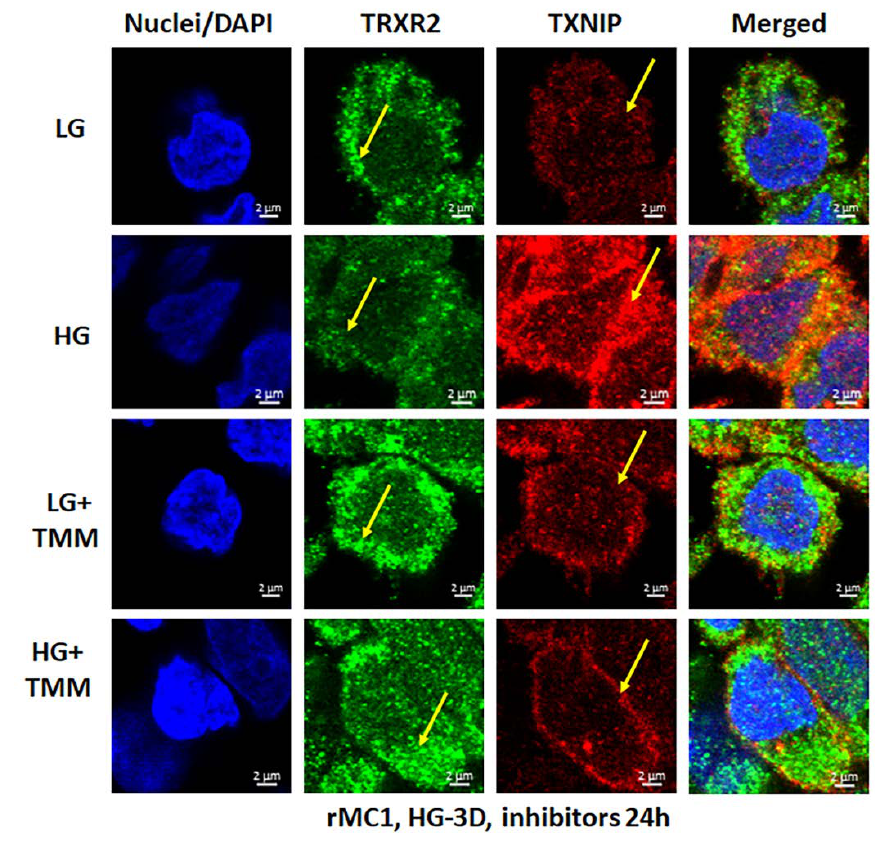
Figure 6. HG reduces mitochondrial thioredoxin reductase 2 (TRXR2) in rMC1. HG exposure of rMC1 for 3 days reduces TRXR2 level compared to LG, while that of TXNIP is increased (first two panels). On the other hand, treatment of rMC1 with triple drug combination TMM increases TRXR2 and decreases TXNIP level under both HG and LG, suggesting a beneficial effect of these drugs on HG-induced redox stress. A representative of n = 3 is shown from fixed-cell confocal imaging at 630 × magnification in a Zeiss confocal